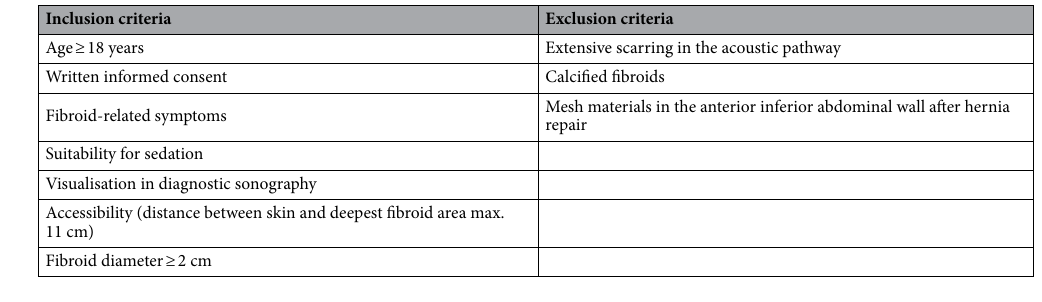
Table 2. Inclusion and exclusion criteria for US-guided